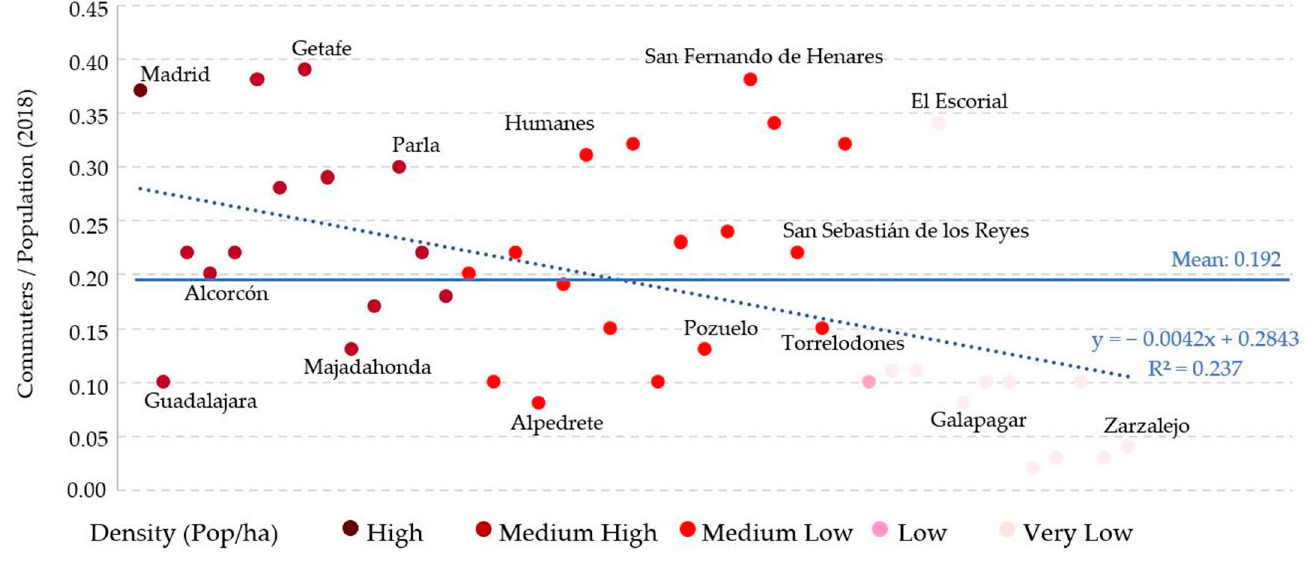
Figure 3. Types of municipalities by density and passengers (in and out) per population in 2018.